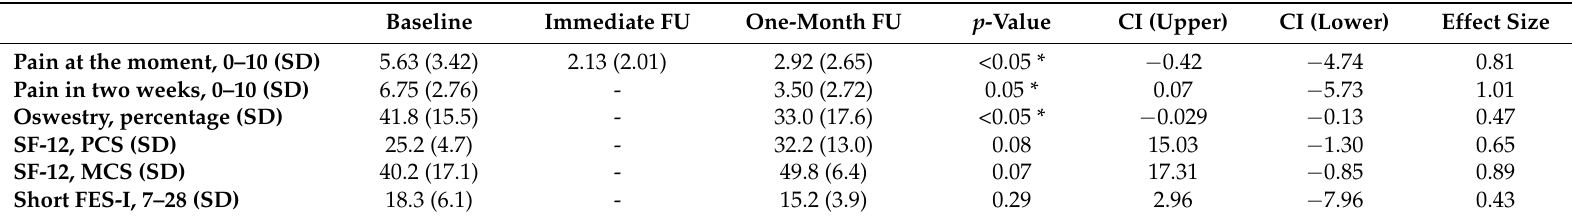
Table 1. Changes in patient-reported outcome measures (PROMs) over time. Results from repeated measure ANOVA (or t -test for baseline versus one-month follow-up comparisons) are presented. Mean (SD: standard deviation), p -values, confidence intervals (CIs), and effect sizes are presented. An asterisk indicates statistical significance.